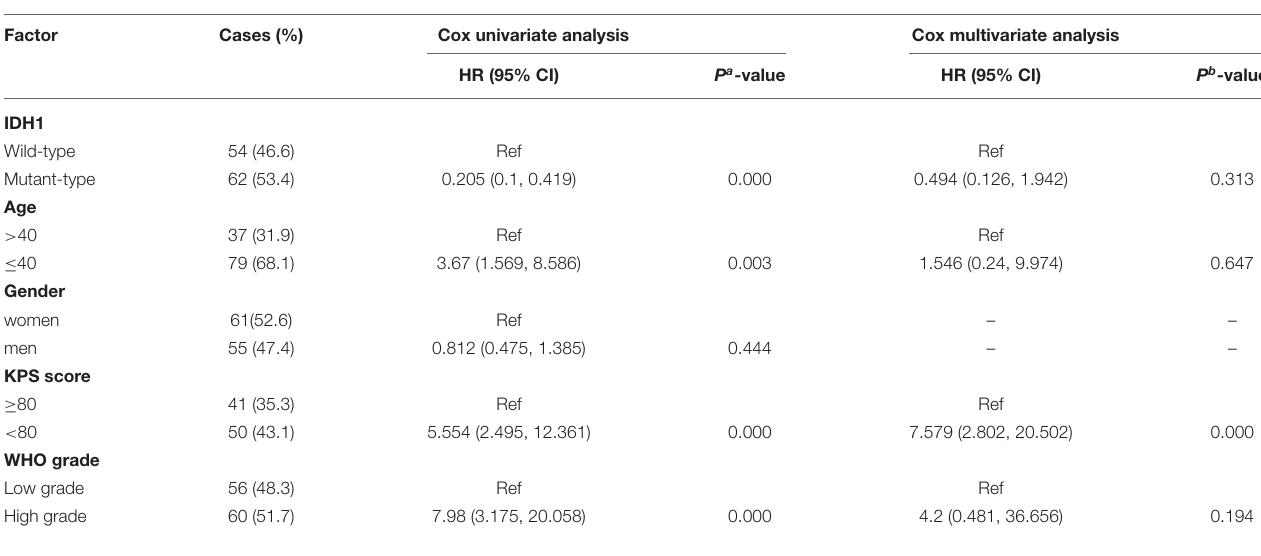
TABLE 2 | Factors affecting the prognosis of